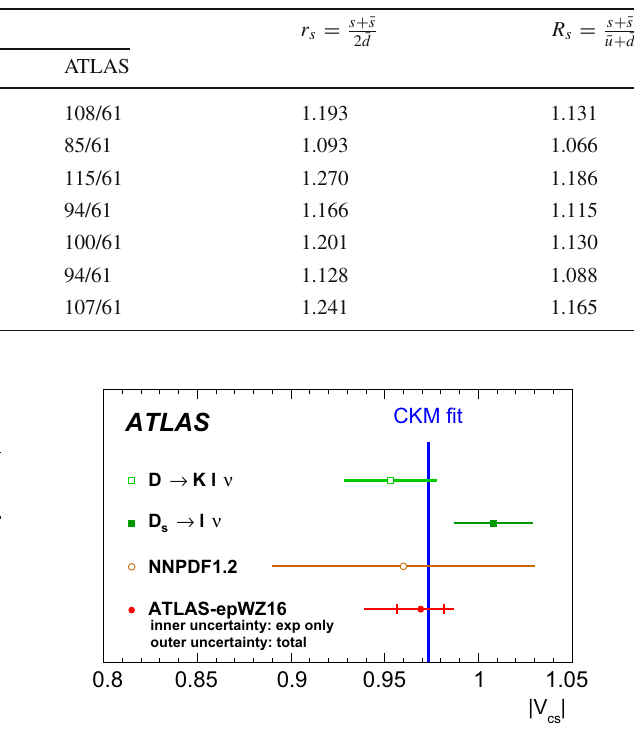
Table 21 Effect of varying the scales for the Drell–Yan data in the NNLO QCD fit. The renormalization, μ r , and factorization, μ f , scales, are expressed relatively to the dilepton mass for NC and the W mass for the CC cross section. Changes of the total fit χ 2 values are almost